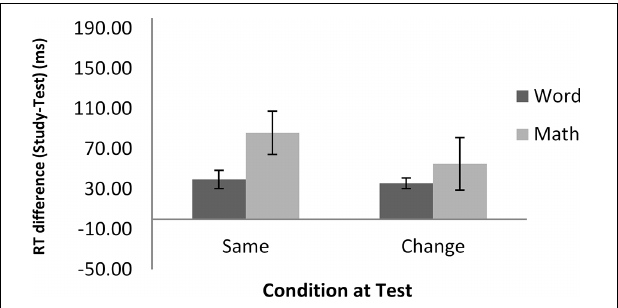
FIGURE 4 | RT differences between the study and test blocks as a function of condition in Experiment 2. Error bars show ± 1 standard deviation of the